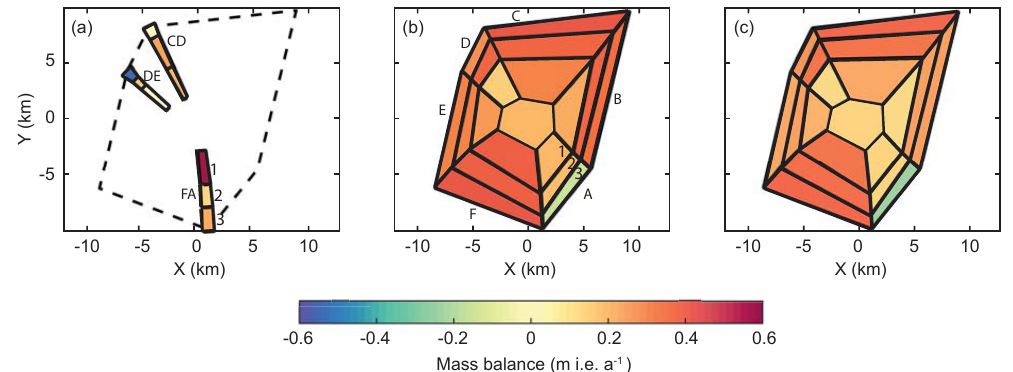
Figure 6. Recent mass balance when the fraction γ of depth-averaged flow speed to the surface flow speed equals 0.8. Results are derived from three set-ups. (a) Flow band set-up. The slopes (FA, CD, and DE) are divided into three columns (1–3, with 1 for most upstream in each slope). (b) Polygon set-up. The ice rise is divided into six slopes (A–F) with three polygons each (1–3, with 1 for most upstream in each slope) and a summit polygon. (c) Grid set-up. The dashed lines in (a) show the extent of the polygon and grid set-ups for comparison.